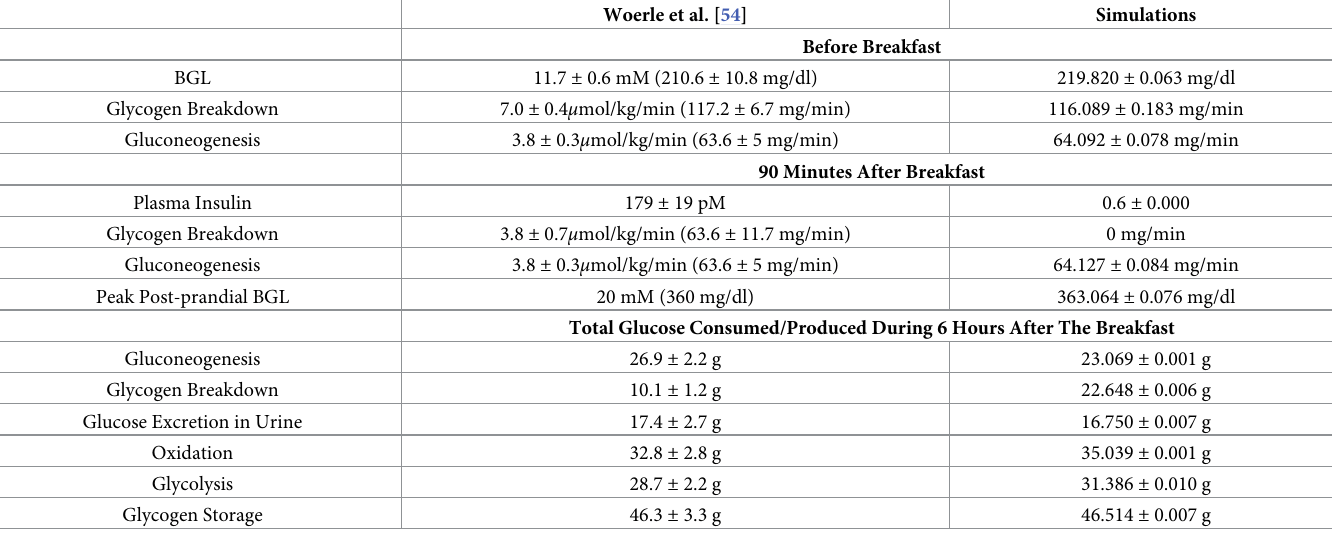
Table 5. Subjects with Type 2 Diabetes: Key measurements from Woerle Et Al. [54] and corresponding results from 30 simulations with different seeds. “Before Breakfast” Simulation Results Were Observed at 9.59AM. All Values Expressed as Mean ± Std Error . Woerle et al.